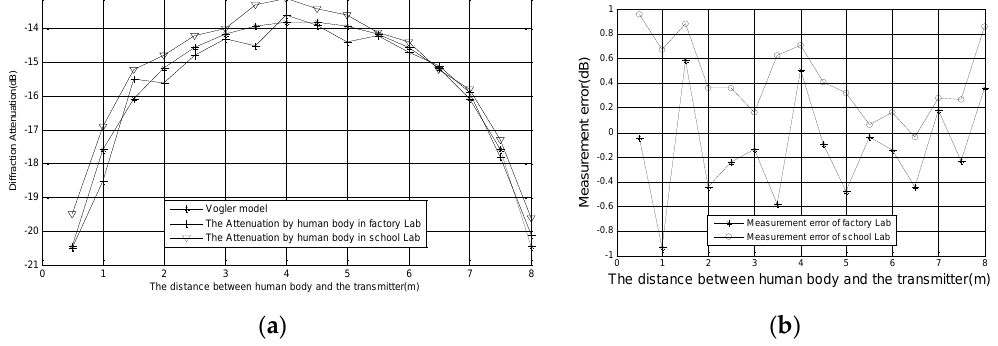
Figure 6. Measurement results and error curves under the human body block: ( a ) Measurement results and theoretical simulation under the human body block; ( b ) Error analysis of two laboratory measurement results.